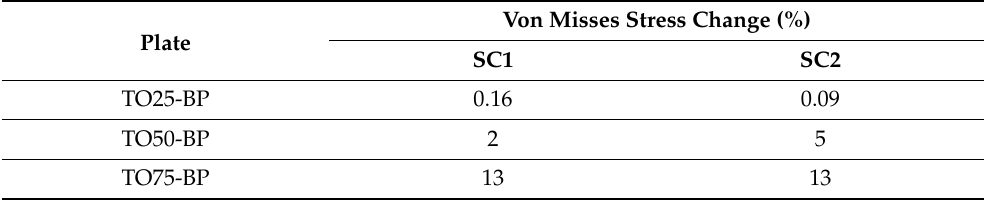
Figure 5. The von Mises stresses at fracture plane 1 for the eight bone-plate models. Table 3. Average change in the von Mises stresses at the fracture planes of the topology-optimized plates based on the initial designs (INT-BP for SC1 is 3.98 ± 0.23 MPa and INT-BP for SC2 is 13.79 ± 0.19 MPa).